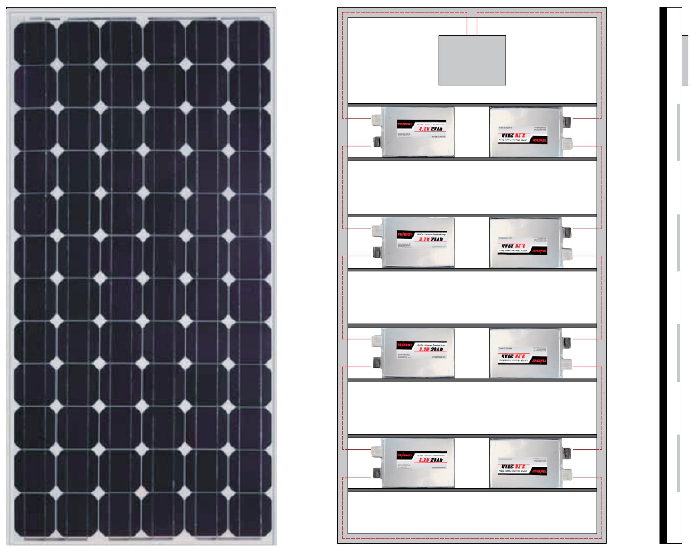
Figure 1. Rendering of the PV module with integrated batteries on the back side.